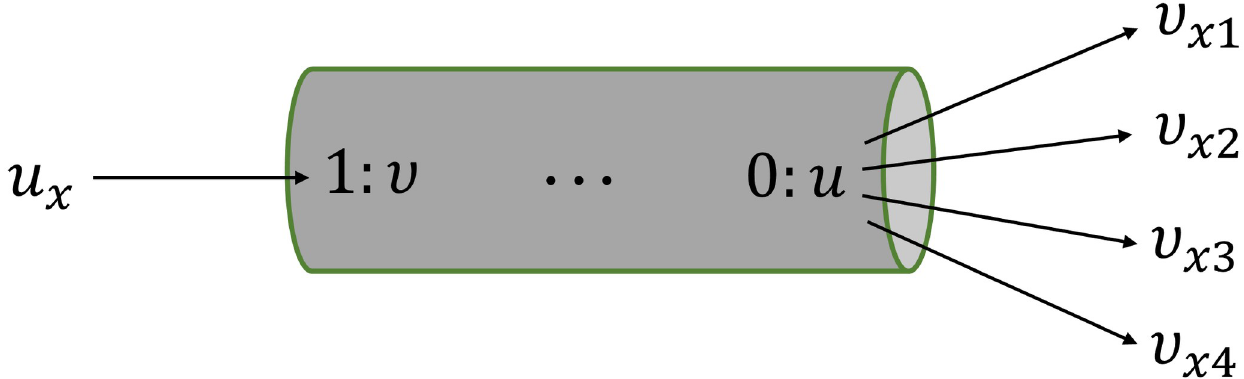
Fig 7. The template bond graph module for intermediate vessels in our version of the ADAN open-loop model. The number of v x variables depends on the maximum number of branches occurring in any segment. Here, four auxiliary variables corresponding to four branches are